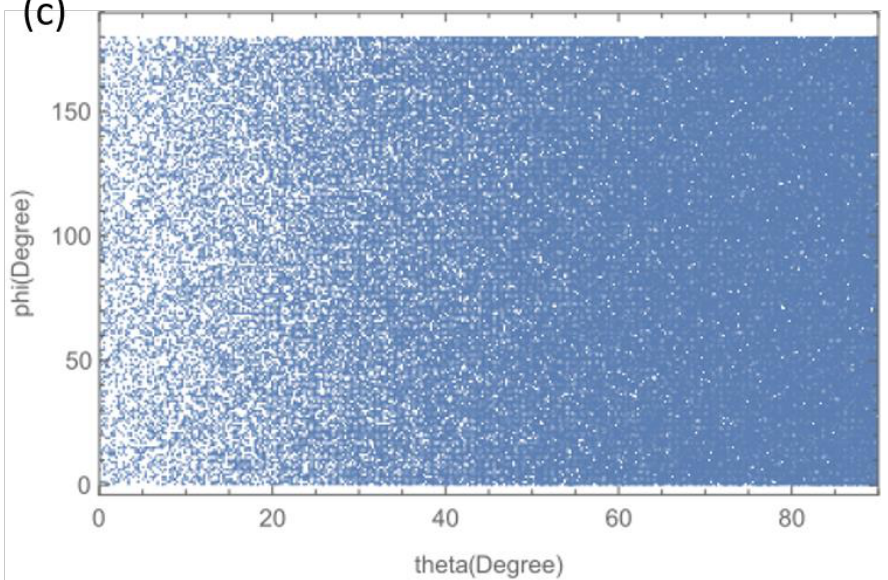
Figure 8. Full θ - φ 2D angular distributions for α = 19° ( a ), α = 60° ( b ), and α = 90° ( c ): α is the inci- Figure 8. Full θ - ϕ 2D angular distributions for α = 19 ◦ ( a ), α = 60 ◦ ( b ), and α = 90 ◦ ( c ): α is the dence angle, θ is the polar angle, and φ is the azimuthal angle, as defined in Figure 7. The blue dots incidence angle, θ is the polar angle, and ϕ is the azimuthal angle, as defined in Figure 7. The blue correspond to the H 3 O + ions ejected from the sample surface. dots correspond to the H 3 O + ions ejected from the sample